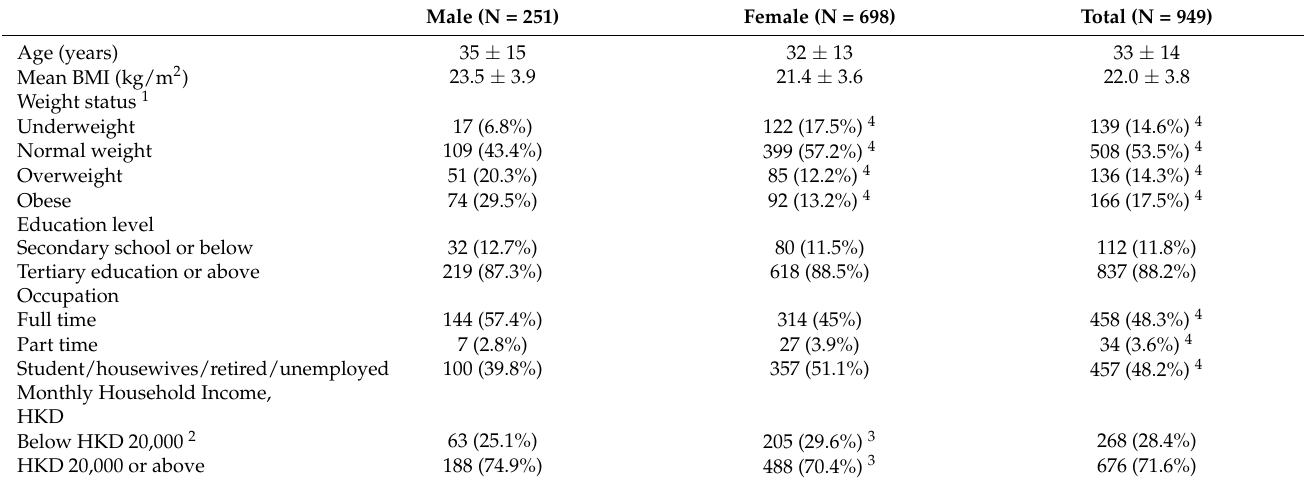
Table 1. Characteristics of